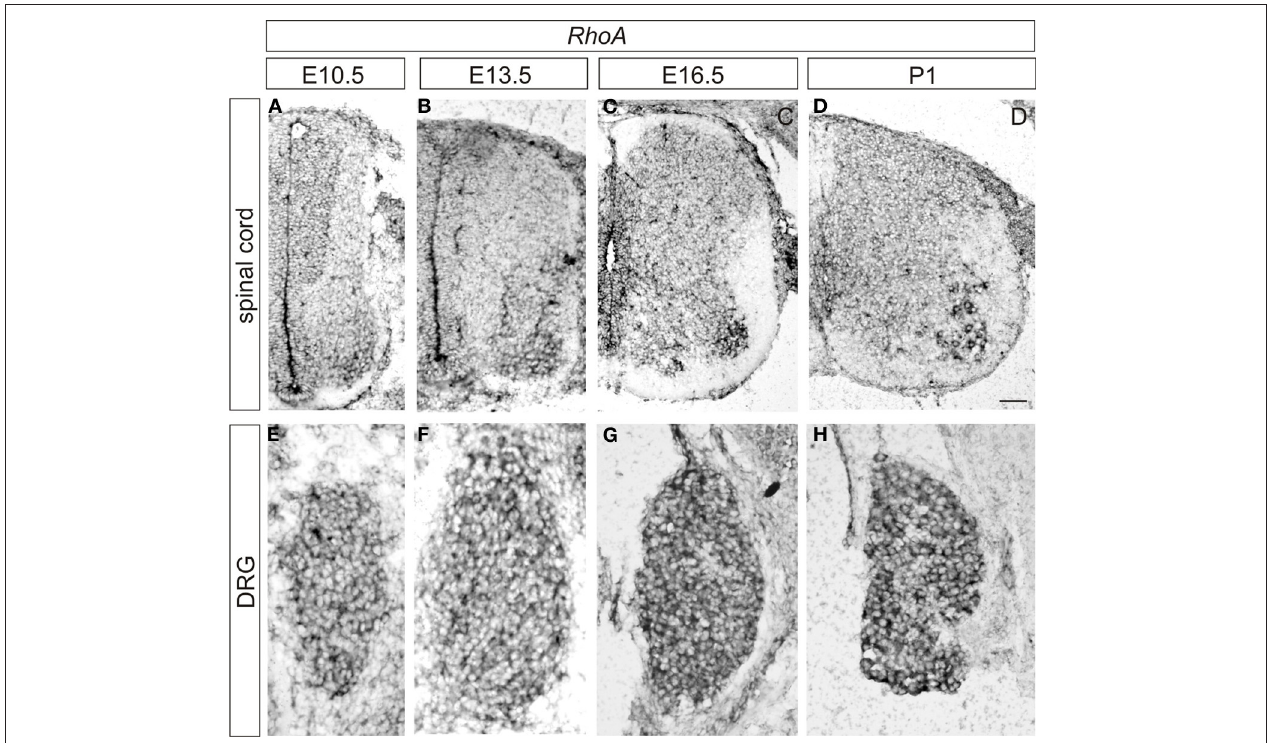
FIGURE 1 | Expression of RhoA in the developing mouse DRG and spinal cord. (A–D) Expression of RhoA in the spinal cord at E10.5 (A) , E13.5 (B) , E16.5 (C) , and P1 (D) . (E–H) Expression of RhoA in the DRG at E10.5 (A) , E13.5 (B) , E16.5 (C) , and P1 (D) . Scale bar, 50 µ m.